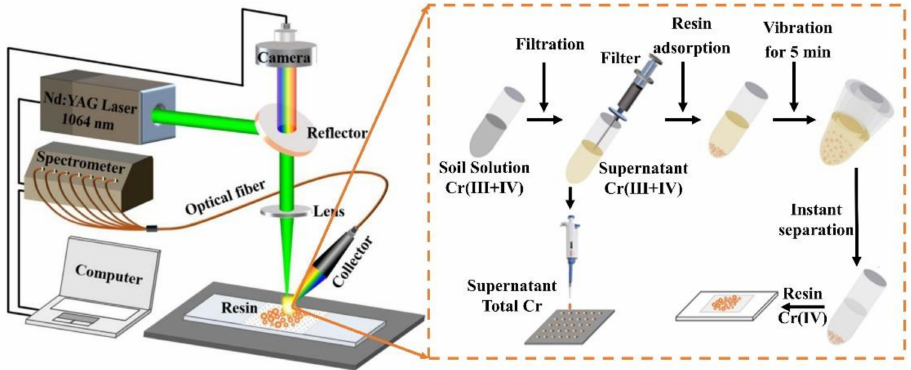
Figure 3. The experimental device of enrichment